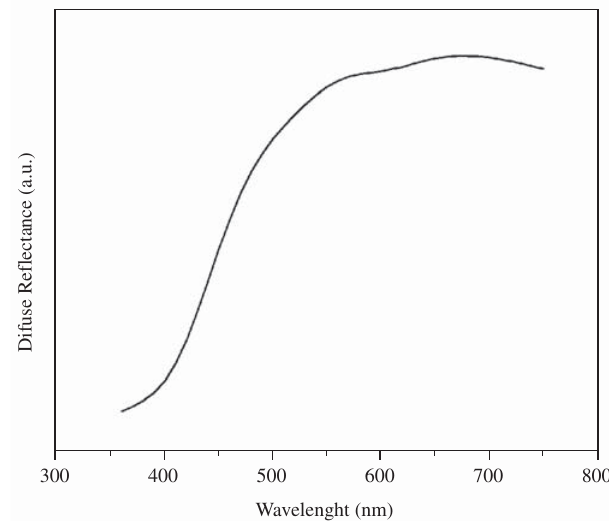
Figure 6. UV-Visible pattern of nickel-doped copper chromites calcined at 900 °C for 8 hours.